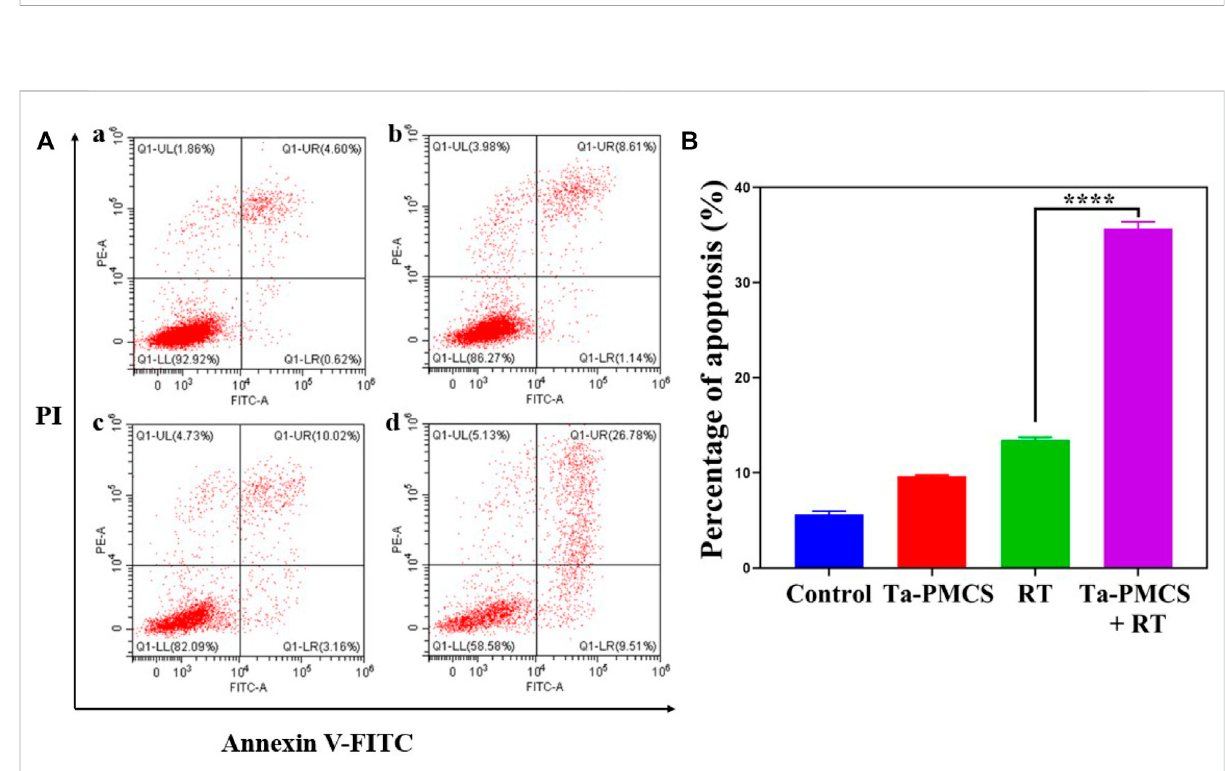
ThemigrationandinvasionabilityofHeLacellstreatedwiththecontrol,Ta-PMCS,RTorTa-PMCS+RTweredetectedbyTranswellassay(scale bar: 50 μ m).